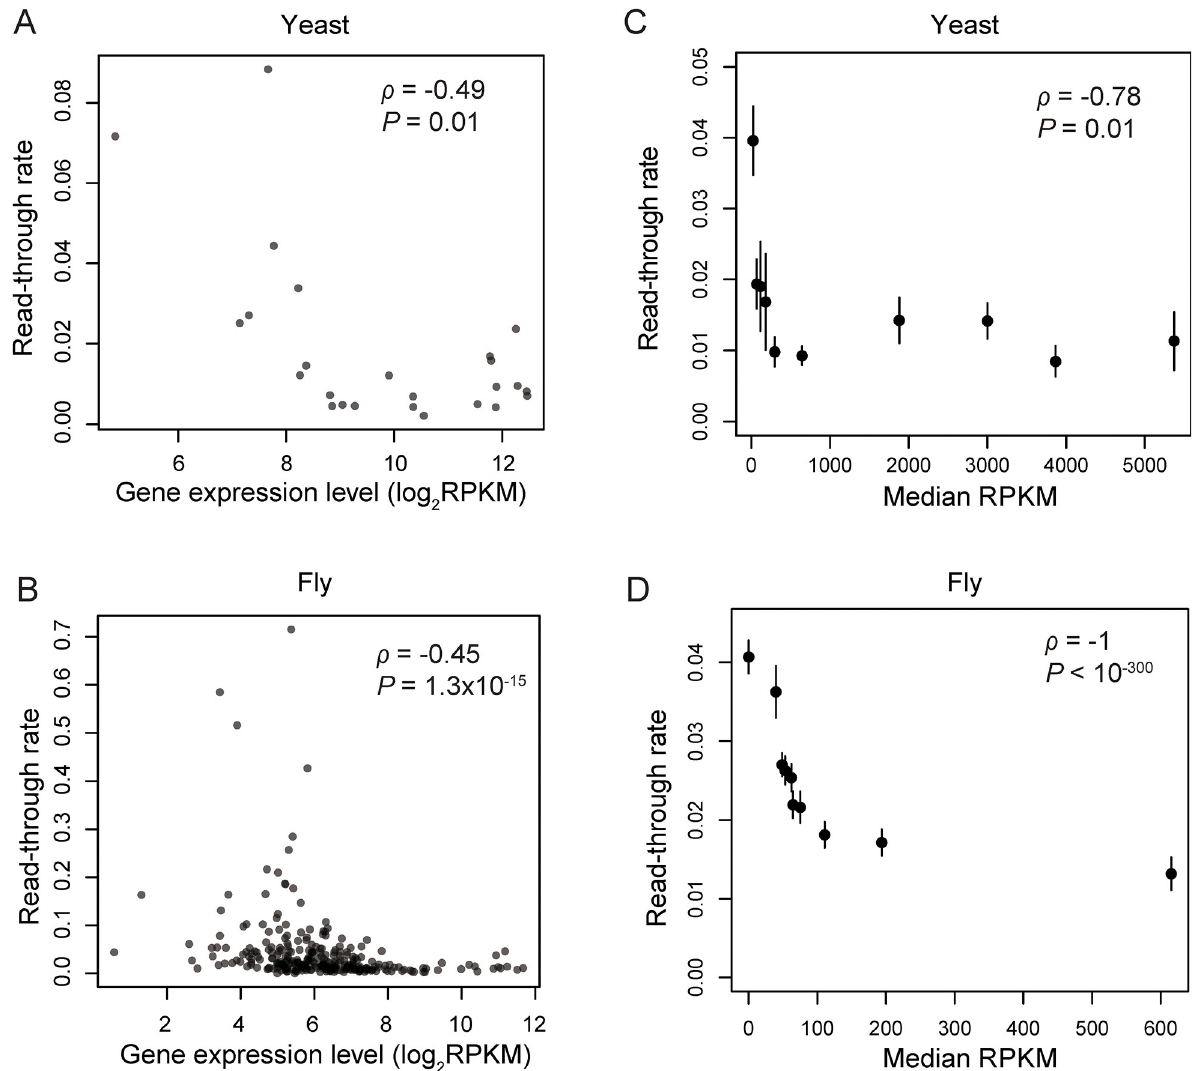
Fig 1. Stop-codon read-through rates decrease with gene expression levels. The read-through rate is estimated by the ribosome profiling RPKM of region 1 relative to that of the coding region. Gene expression level is measured by log 2 (RPKM) of the coding region based on mRNA sequencing. ( A-B ) The read-through rate of a gene declines with its expression level among 25 genes in yeast ( A ) and 283 genes in fruit fly ( B ) reported to undergo stop-codon read-through in [9]. Each dot is a gene. ( C-D ) The overall read-through rate of a group of yeast ( C ) or fruit fly ( D ) genes of similar expression levels declines with the median expression level of the group of genes. In each species, genes are divided into 10 bins according to their expression levels such that the total expression level (measured by RPKM) of each bin is the same. Error bars show standard deviations of the overall read-through rate estimated by bootstrapping genes in each bin. Error bars are too small to be visible for some bins. A total of 3,688 yeast genes and 9,519 fruit fly genes are included in the analysis. Spearman’s rank correlation ( ρ ) and associated P -value are shown.